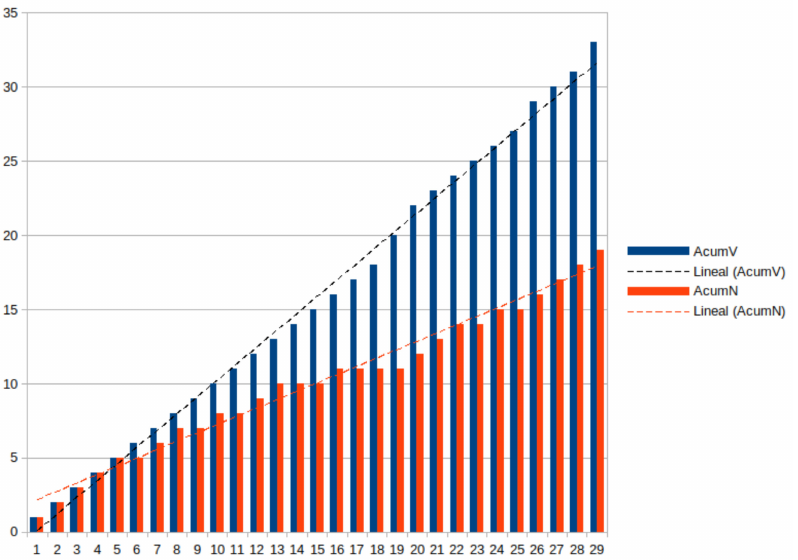
Figure 2. Cumulative distribution for verbs ( AcumV ) and nouns ( AcumN ) for game #7.